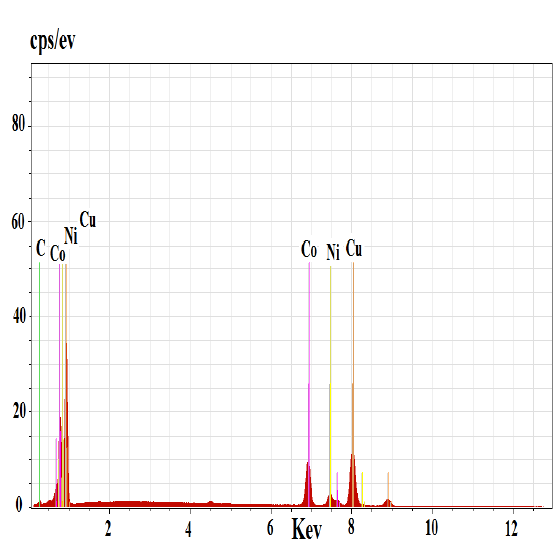
Fig. 2 . EDX analysis of Ni-Co (3nm)/Cu(2nm)